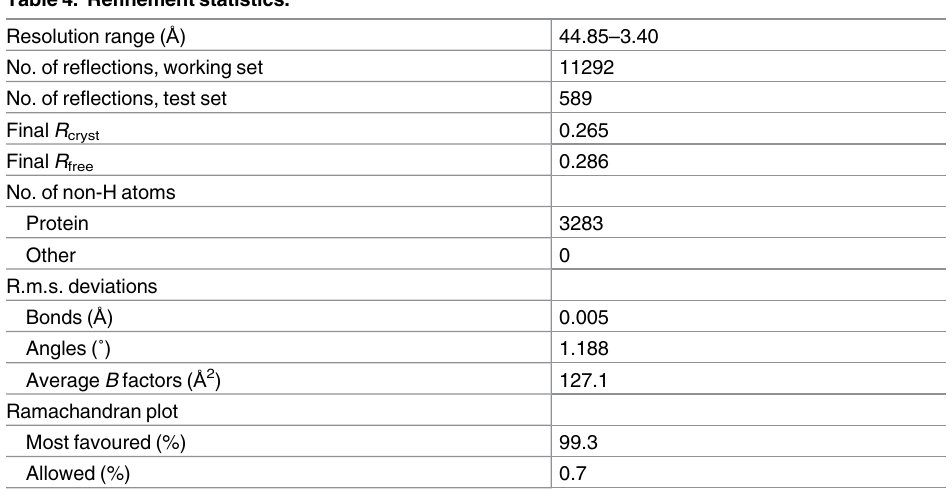
Table 4. Refinement